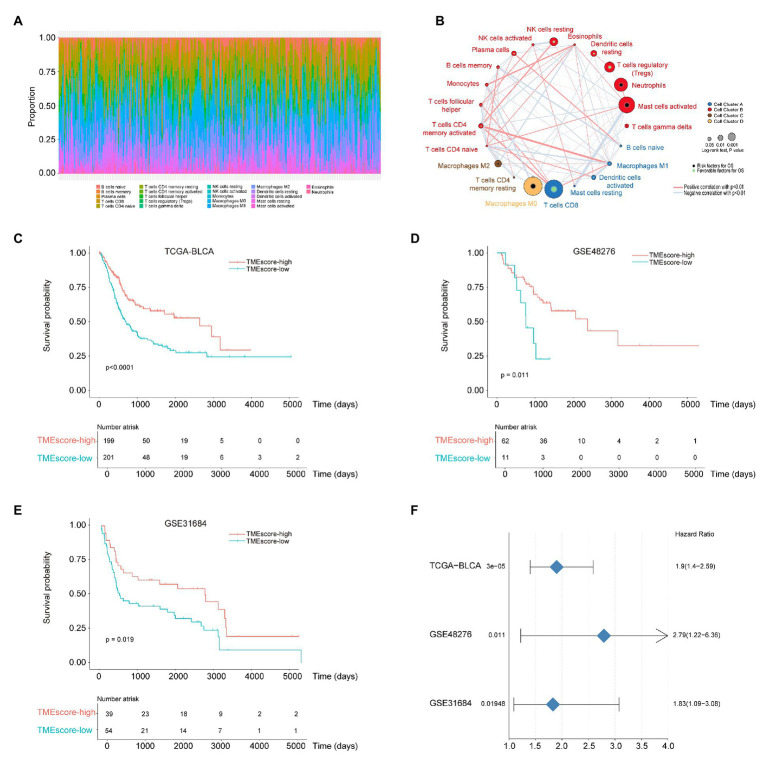
The tumor microenvironment (TME) subtypes are associated with the prognosis of bladder cancer (BLCA). (A) The proportions of 22 types of immune cells. (B) The cellular interactions of 22 types of immune cells and their correlations with overall survival (OS). Cell cluster A, blue; Cell cluster B, red; Cell cluster C, brown; and Cell cluster D, orange. The size of the circle indicates the degree of correlation with the OS. Risk factors for OS are indicated in black, and favorable factors for OS are indicated in green. The thickness of the line indicates the degree of cellular interactions; the red lines indicate positive correlations, and the blue lines indicate positive correlations. (C–E) Kaplan-Meier curves for OS of the cancer genome atlas BLCA (TCGA-BLCA), GSE48276 and GSE31684 cohort, respectively. (F) The forest plot for survival analysis of different data sets.